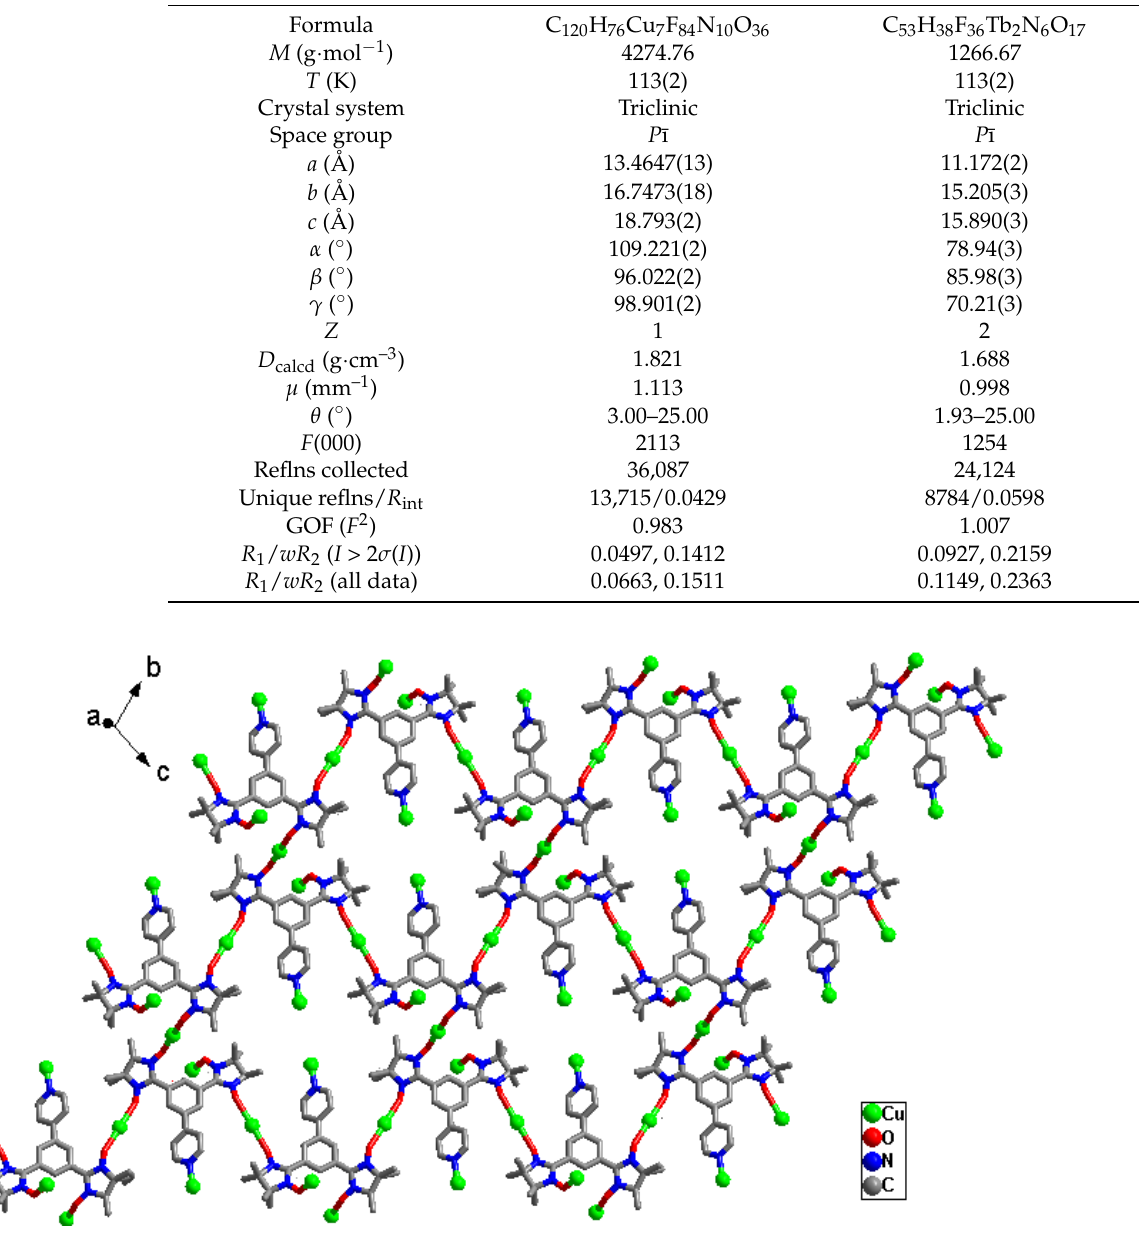
Figure 2. Network structure of compound 1 . The H atoms and bidentate hfac − ligands are deleted.